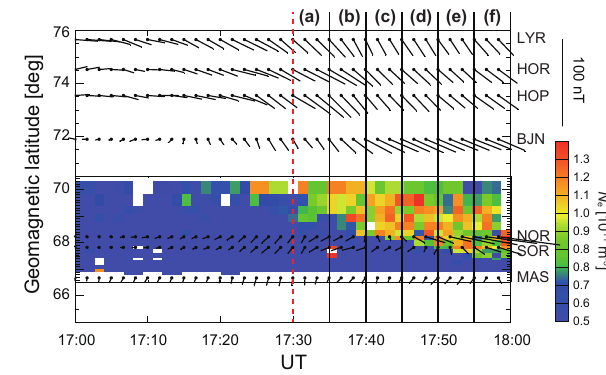
Figure 2. Observations from EISCAT and the IMAGE magnetome- ter during the substorm on 4 December 2013. The keogram was reproduced from the N e observed by the meridional scans at an al- titude of 210km, with overplotted convection vectors at an altitude of 120km from the IMAGE meridian chain. The red dashed verti- cal line indicates the onset time ( ∼ 17:30UT), and the remaining 30min is divided into six sections according to Fig.